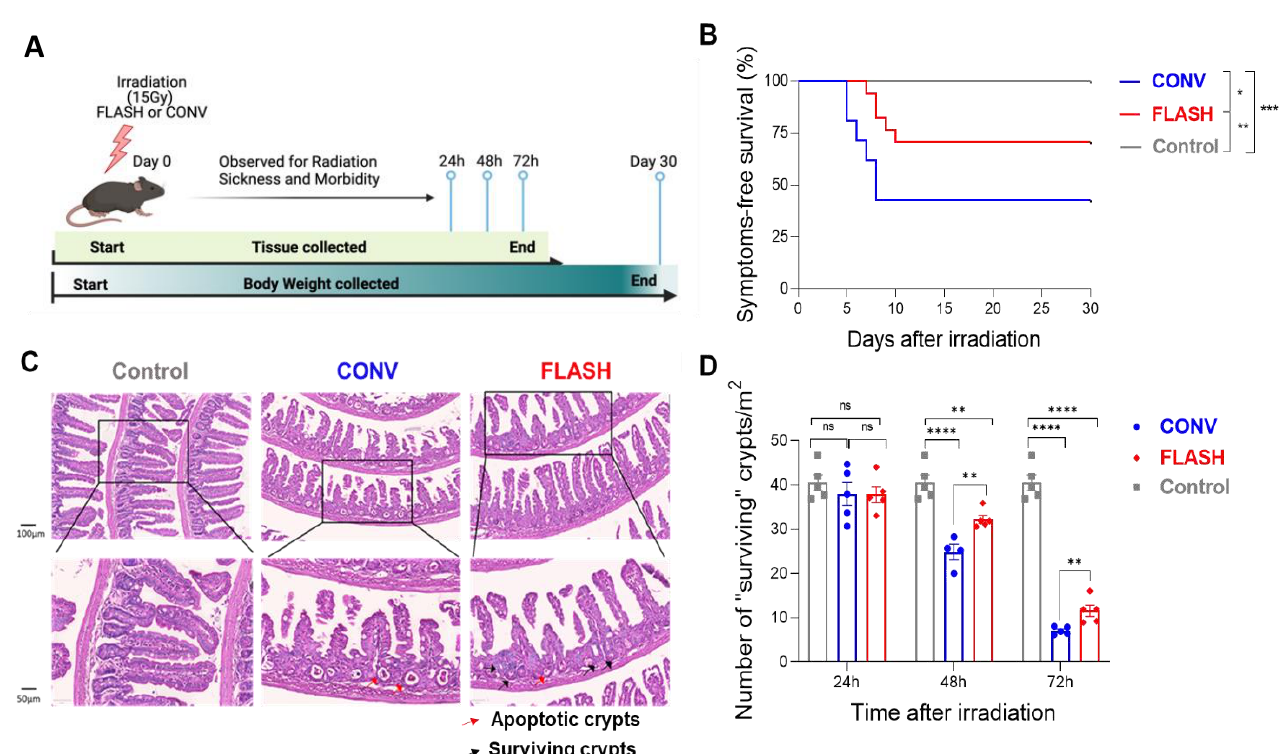
Figure 2. At CHUV, ultra-high dose rate FLASH RT led to higher survival and reduced gastrointestinal toxicity compared with CONV dose rate RT. ( A ) Schematic for radiation treatment and follow-up studies at CHUV. ( B ) Kaplan–Meier plot of survival up to 30 days post-irradiation (mice were euthanized after meeting the CHUV criteria for morbidity.). Data shown are mean ± SEM pooled from 2 independent experiments (21 mice in the CONV RT group, 17 mice in FLASH RT, and 20 mice in Control). FLASH RT-treated mice survived longer than CONV RT-treated mice. ( C ) H&E-stained Swiss-roll sections of jejunum; scale bar in upper panels indicates 100 µ m; scale bar in the magnified view in the lower panels is 50 µ m. Red arrows point to apoptotic crypts and black arrows to surviving crypts. ( D ) Numbers of surviving crypts at 24–72 h after a single 16-Gy dose of CONV or FLASH RT. The numbers of surviving crypts were no different between the Control, CONV, and FLASH groups at 24 h, but were significantly higher in the FLASH group vs. the CONV group at 48 and 72 h. ns–not significant, * p < 0.05; ** p < 0.001; *** p < 0.0001; **** p < 0.00001 (log-rank